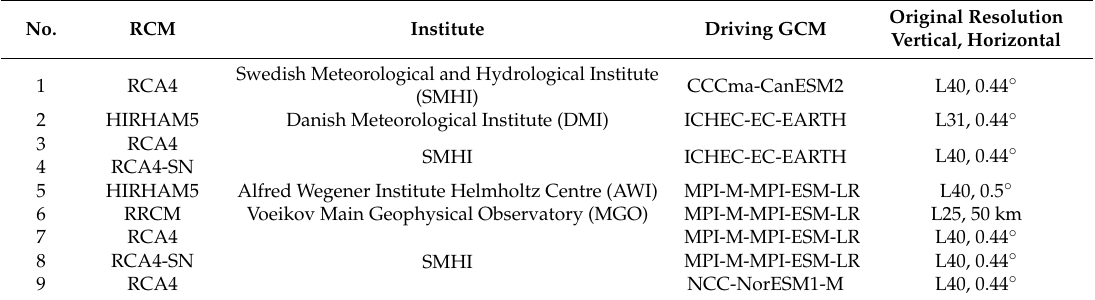
Table 2. Nine regional climate models (RCMs) available for the Arctic.